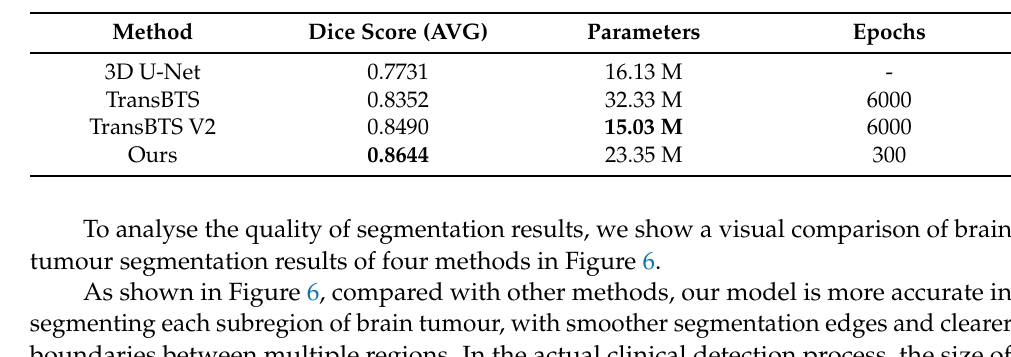
Table 4. Comparison of parametric numbers in the BraTS 2020 dataset. AVG represents the average of WT, ET and TC, and Parameters represent the parametric size of the model.